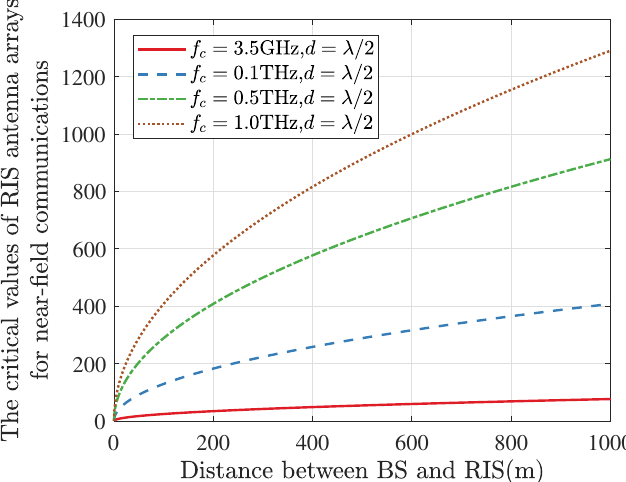
Figure 3. RIS antenna array size in relation to near-field communication.